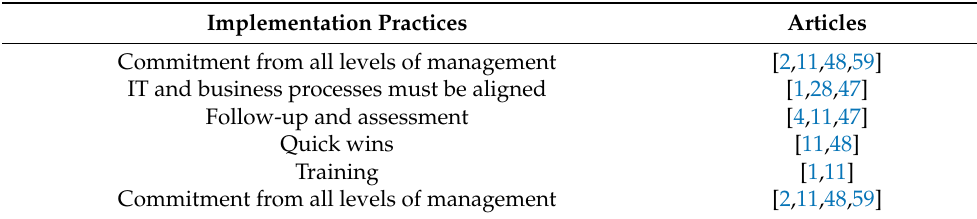
Table 5. ITSM Implementation